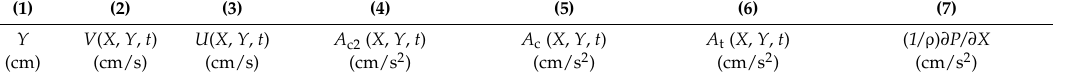
Table A3. A list of velocity data for T = 7.25 and calculation of A c2 and A c (= A c1 + A c2 ), A t and ( 1/ ρ ) ∂ P / ∂ X . Note that partially depth-averaged values for A c2,da , A c,da , A t,da and [( 1/ ρ ) ∂ P / ∂ X ] da are all shown at the bottom of the